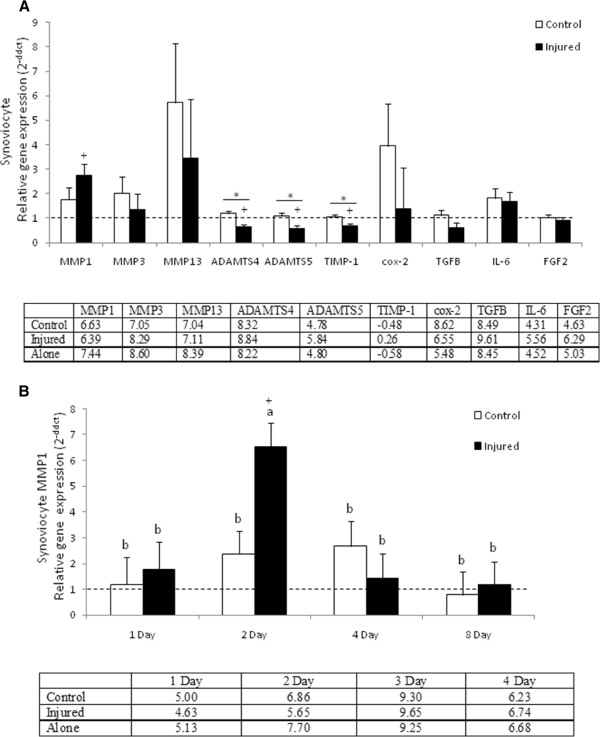
Synoviocyte gene expression. (A) Gene expression data for synoviocytes in the presence of injured or control cartilage. Data presented as mean relative expression across all time points for each culture condition (± SEM) * denotes statistically significant difference between pairs, + denotes statistically significant difference from baseline, p-value < 0.05. (B) MMP-1 expression was significantly affected by both treatment and duration in culture with a significant increase in expression in synoviocytes cultured with injured cartilage after 48 hours. Synoviocyte gene expression levels are relative to synoviocytes cultured alone. Bars represent mean (± SEM), bars with the same letter for each pathology are not significantly different from each other, significance set at alpha (p-value) = 0.05, n = 6. Main effects or interactions were evaluated in the AOV table with a predictive F-value (Pr > F).